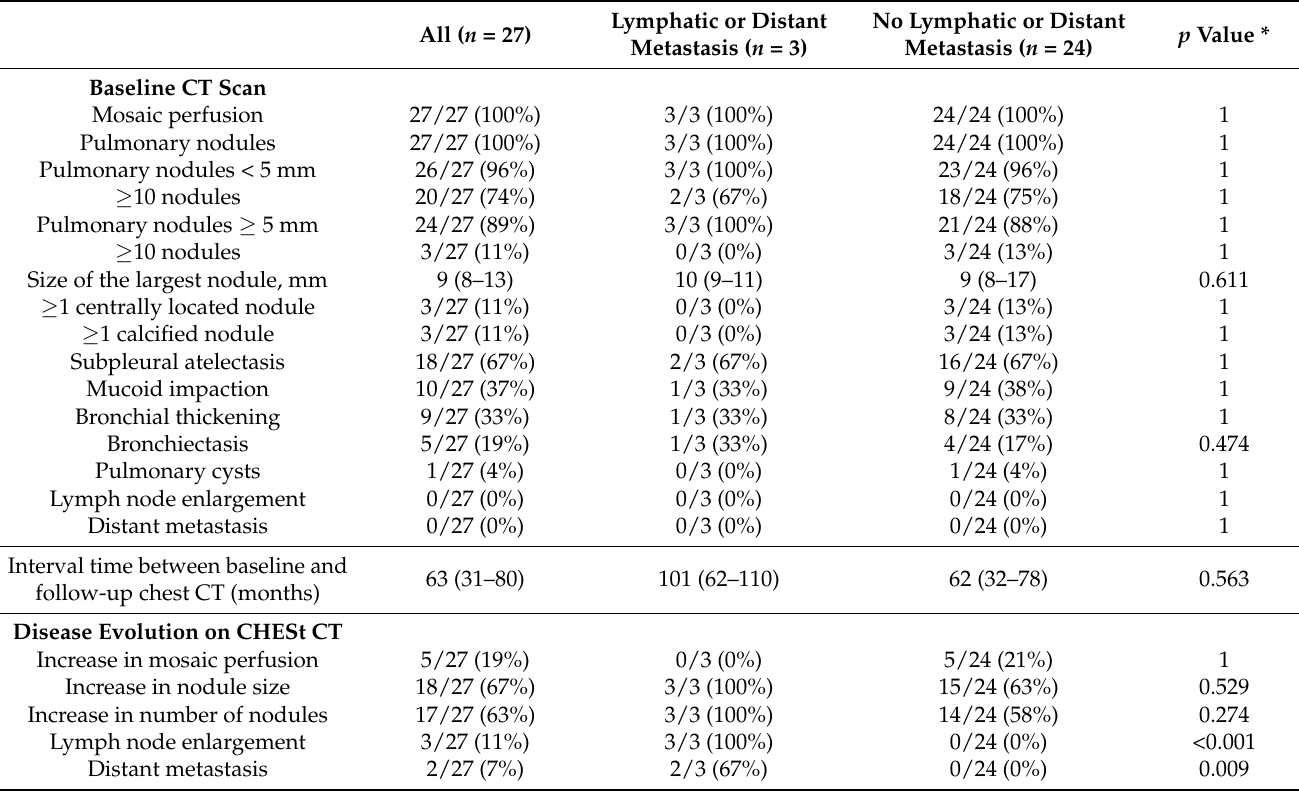
Table 2. Imaging findings in DIPNECH